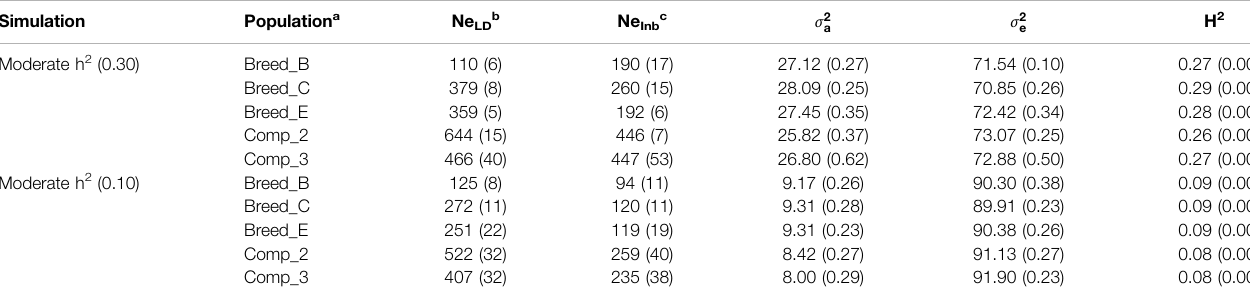
TABLE 1 | Average (SE) effective population size based on the linkage disequilibrium (Ne LD ) and realized inbreeding (Ne Inb ) methods, additive genetic variance ( σ 2 a ), residual variance ( σ 2 a ), and heritability (h 2 ) estimates of the trait in simulated sheep populations.